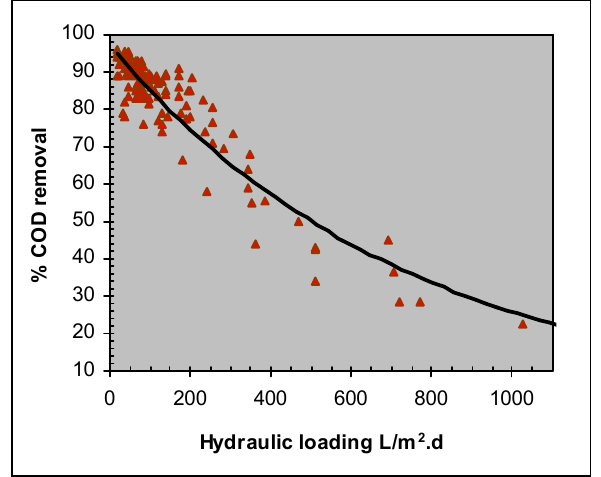
Figure 6: Effect of hydraulic loading on % COD